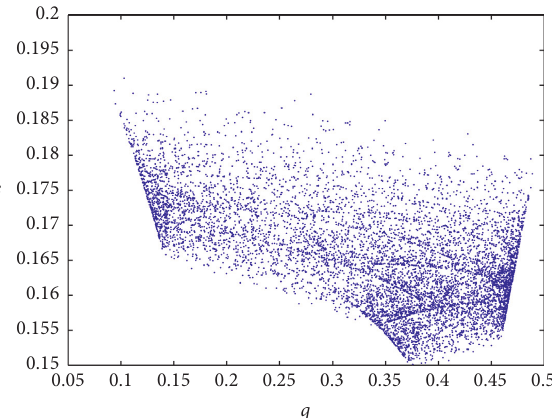
Figure 8: The chaotic attractor of dynamic system (25) when α